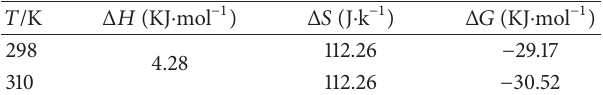
Table 3: Thermodynamic parameter of interaction between HSA and